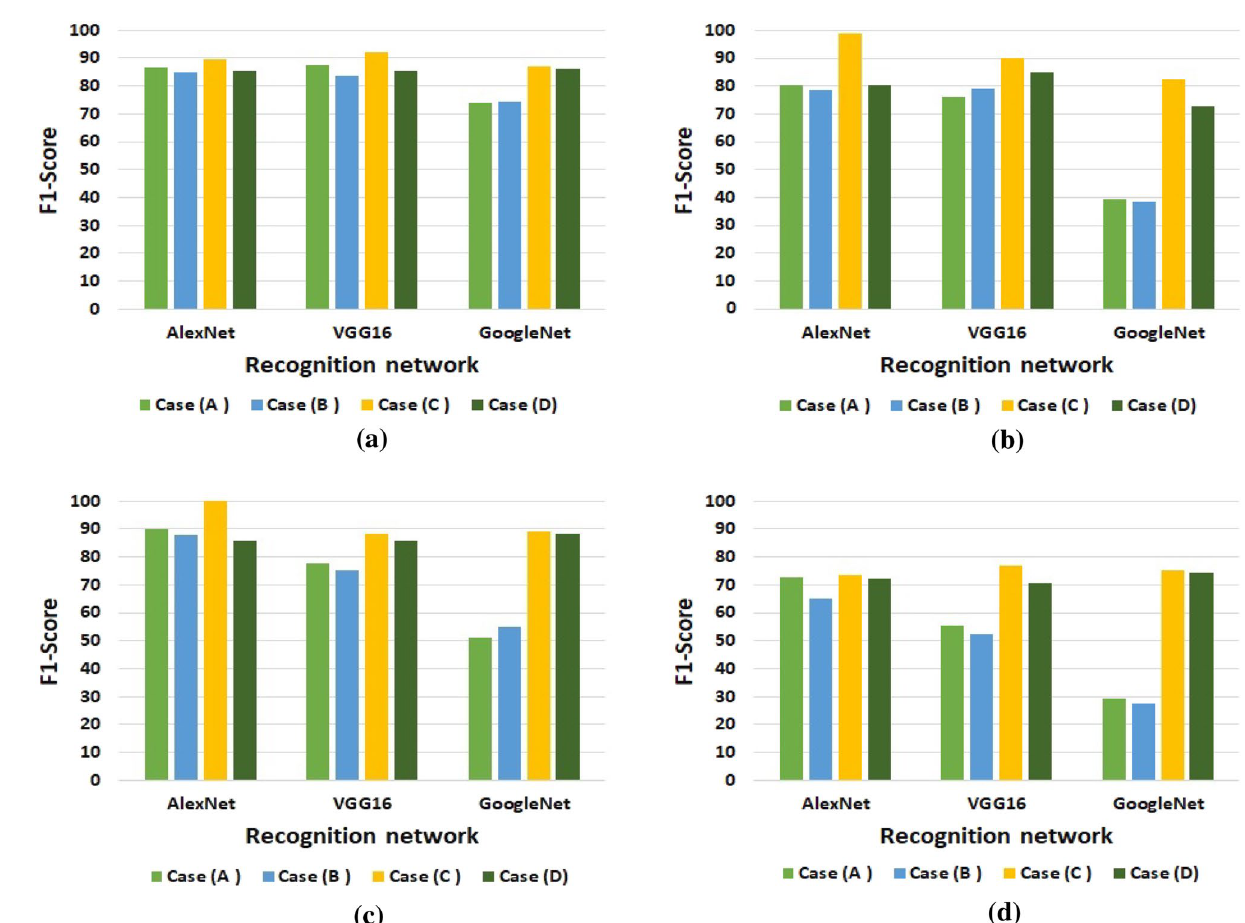
Figure 10. Visualization for the F1-Score recorded by each model under the different training cases for ( a ) Latin dataset, ( b ) Malay(Jawi-Arabic) dataset, ( c ) Korean dataset, and ( d ) Sanskrit(Indo-Aryan)